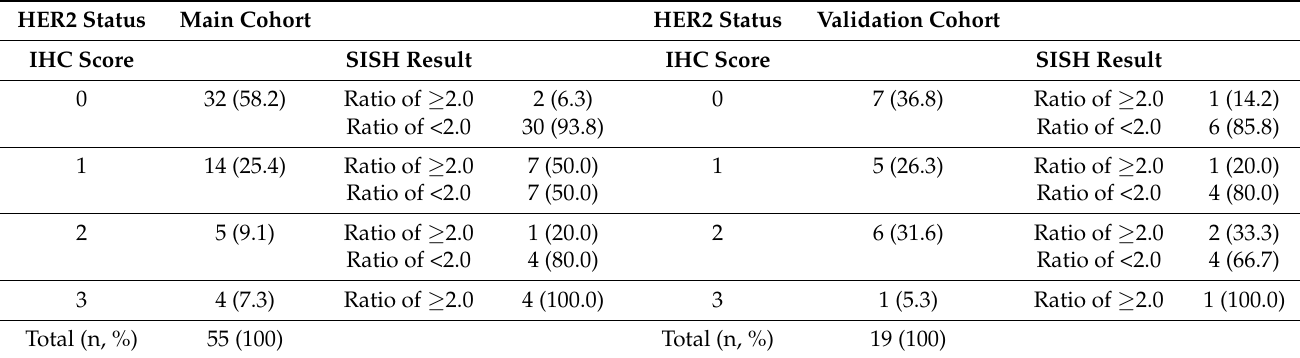
Table 2. Comparison of HER2 immunohistochemistry (IHC) and Silver In Situ Hybridization (SISH) results.